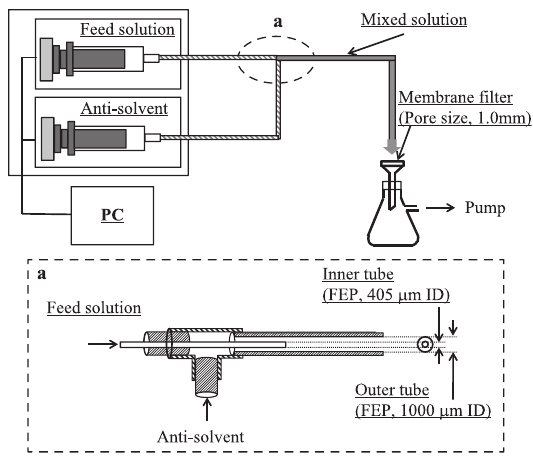
Fig. 8 Schematic of the experimental apparatus in the continuous